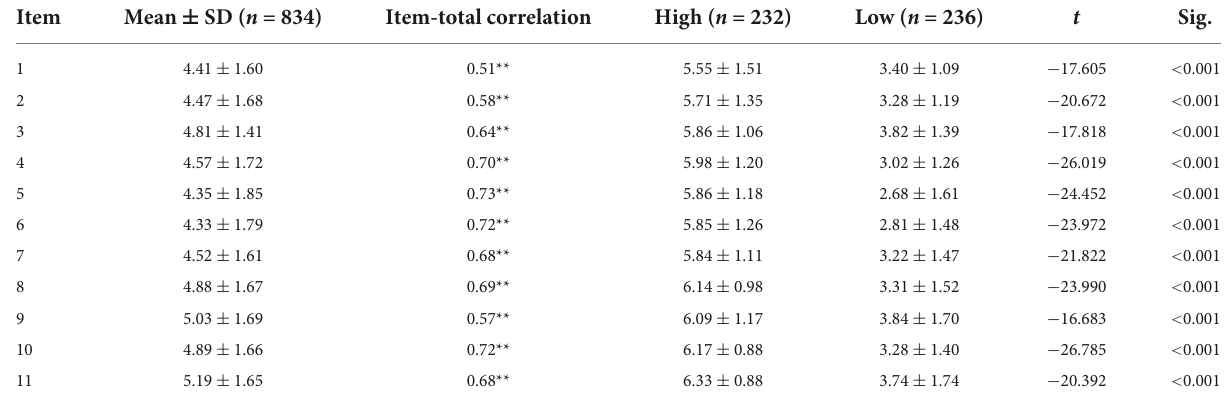
TABLE 1 Results of the item analysis.